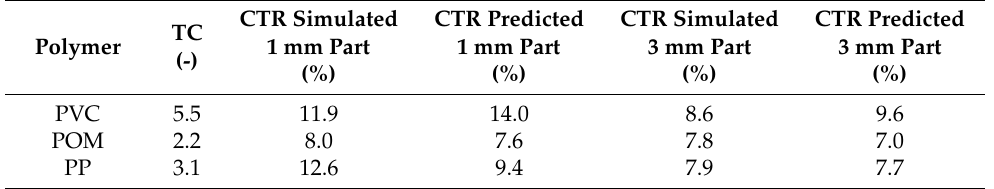
Table A3. Temperature coefficient (TC) and cycle time reductions (CTR) for the validation of the correlation model.